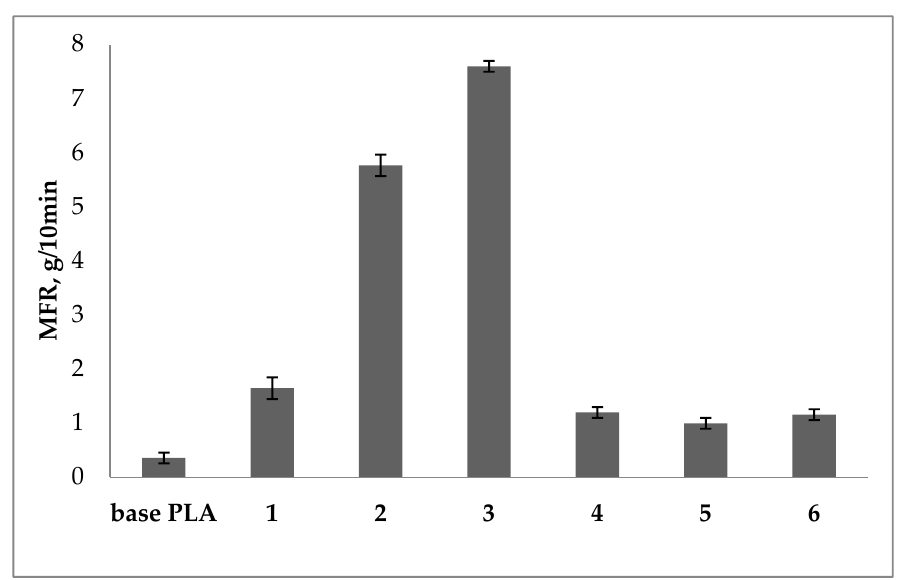
Figure 3. MFR values of base and plasticized PLA.